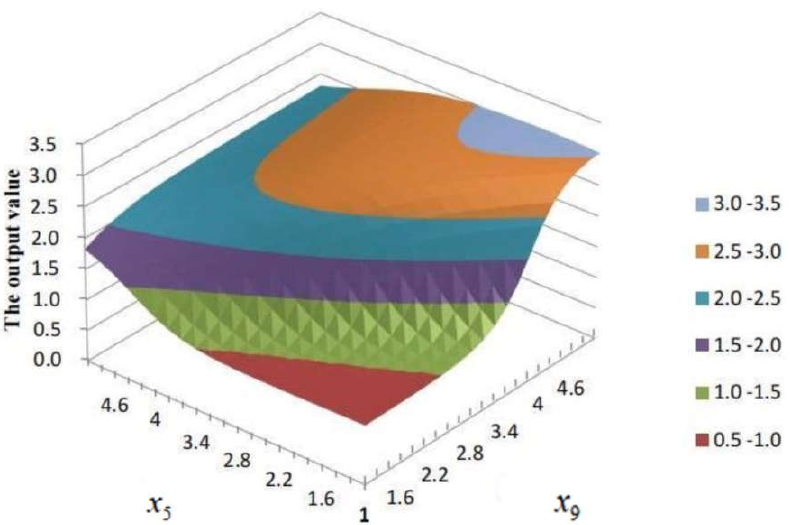
Figure 2. The nonlinear relationship between the indicator x 5 and x 9 , and the output value of the established BPNN model.